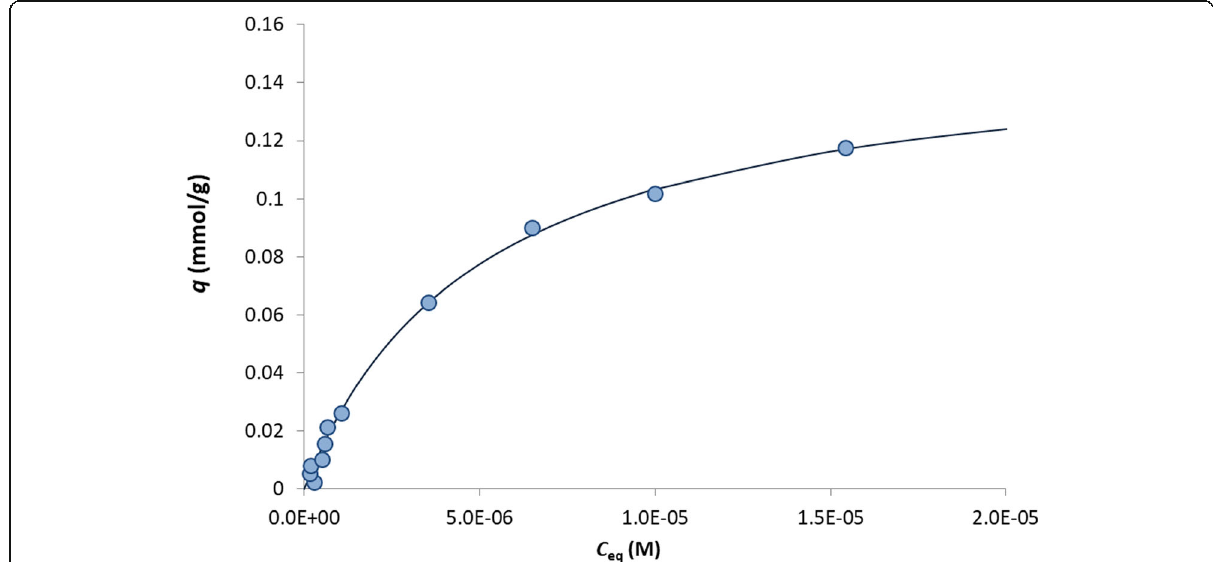
Fig. 1 Sorption isotherm of EBT on the CC. w = 0.02 g; V = 25 mL at pH = 10; T = 25 °C. The continuous line is the fitting according to the Langmuir equation (see parameters in Table 1)